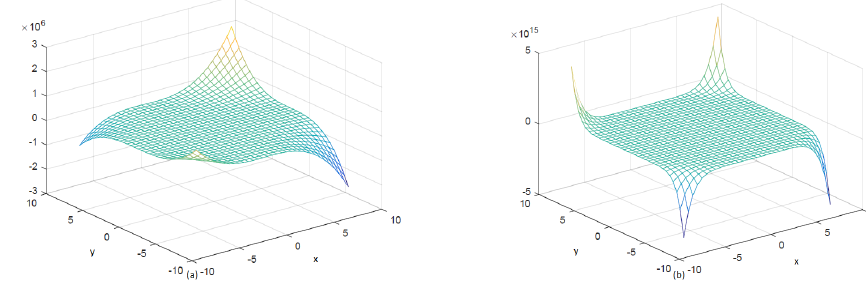
Figure 17: Plotting of (a) M-polynomial and (b) NM-polynomial of Raloxifene. Corolary 2.16. Let G be the molecular graph of Raloxifene.